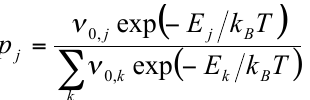
Fig. 2. One AKMC step corresponding to the migration of one vacancy (in reality, it is rather one of its neighbouring atoms that migrates to it). The figure shows the migration of the hatched atom to the vacancy, situated on the front bottom left corner of its BCC cubic cell, in plain lines. The dashed line shows the BCC cell of